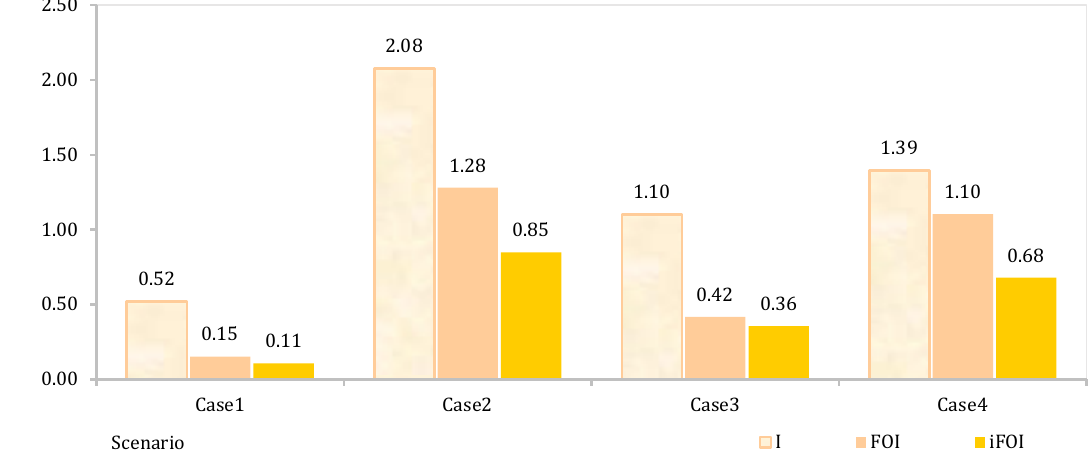
Figure 12. Evaluation of the objective function of each controller for each studied case.